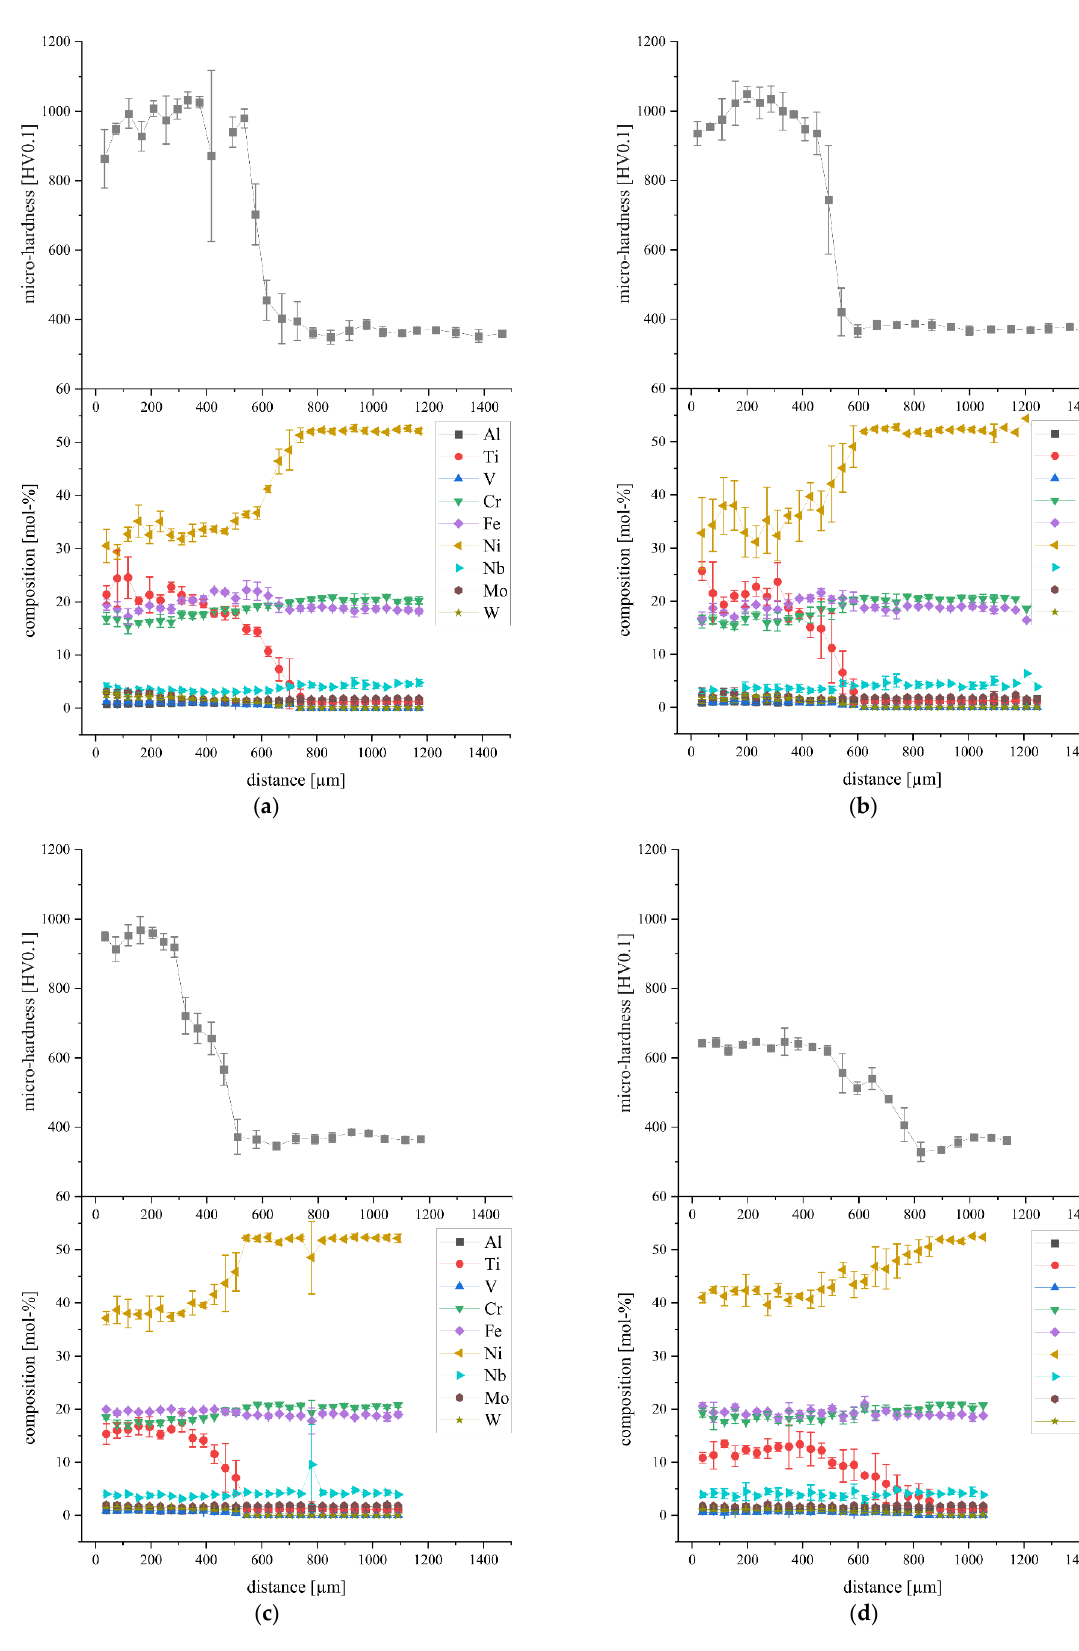
Figure 14. Micro ‐ hardness and chemical composition plotted over the distance to the samples’ top surface: ( a ) MPEA_50, ( b ) MPEA_67, ( c ) MPEA_83, ( d ) MPEA_100; measuring schematic shown in Figure 13.